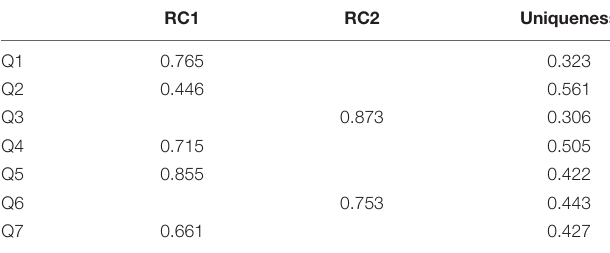
TABLE 2 | Component Loadings of the